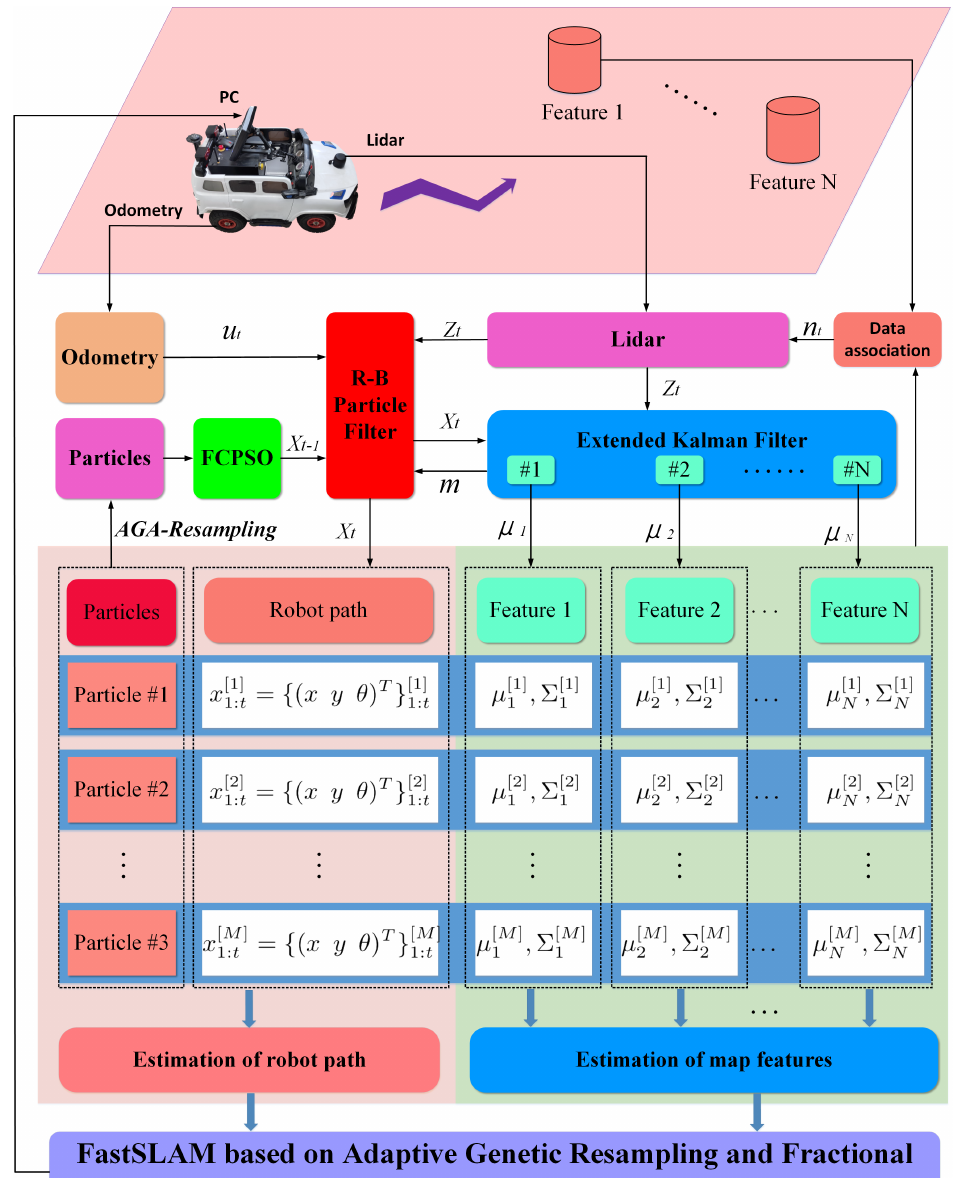
Figure 4. Scheme of